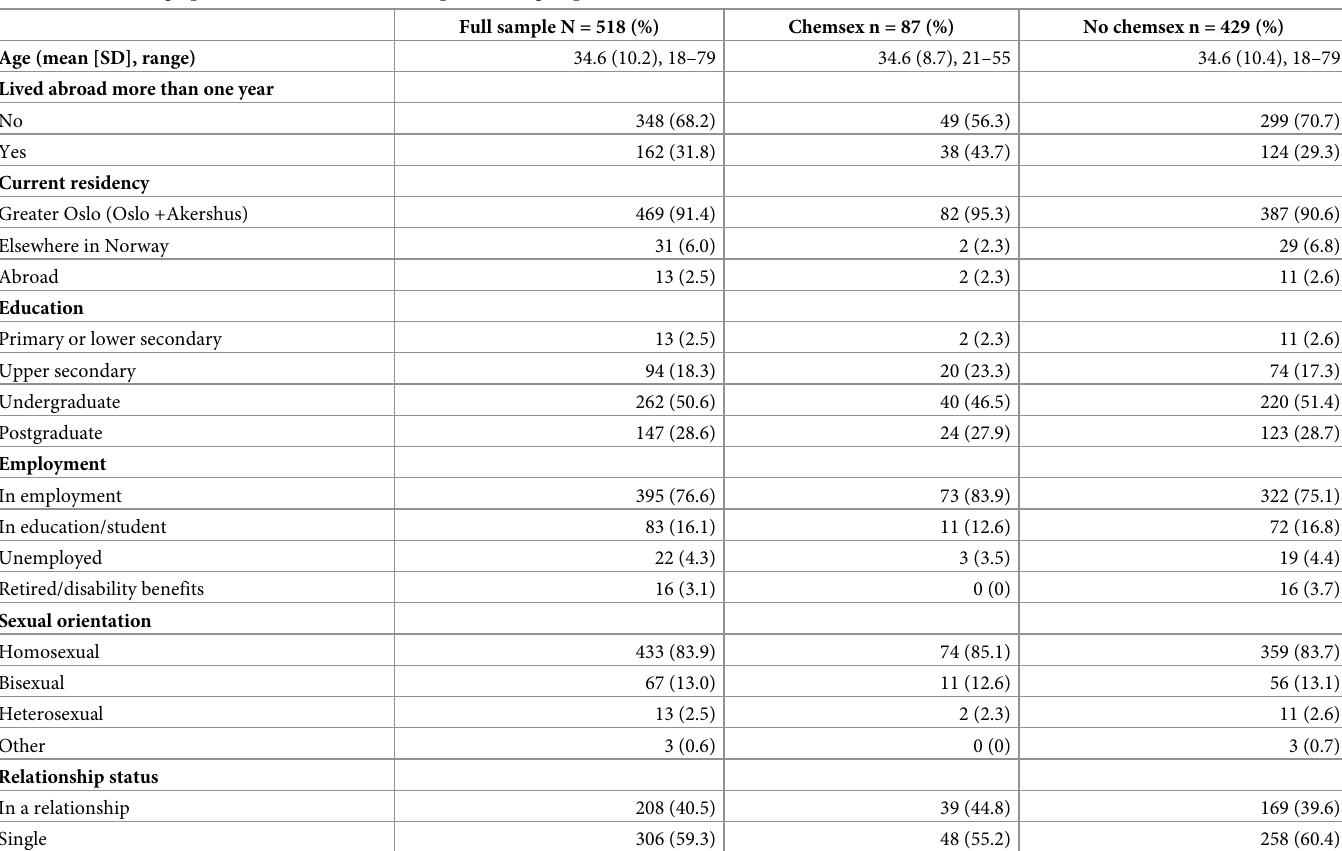
Table 1. Sociodemographic characteristics of the sample and